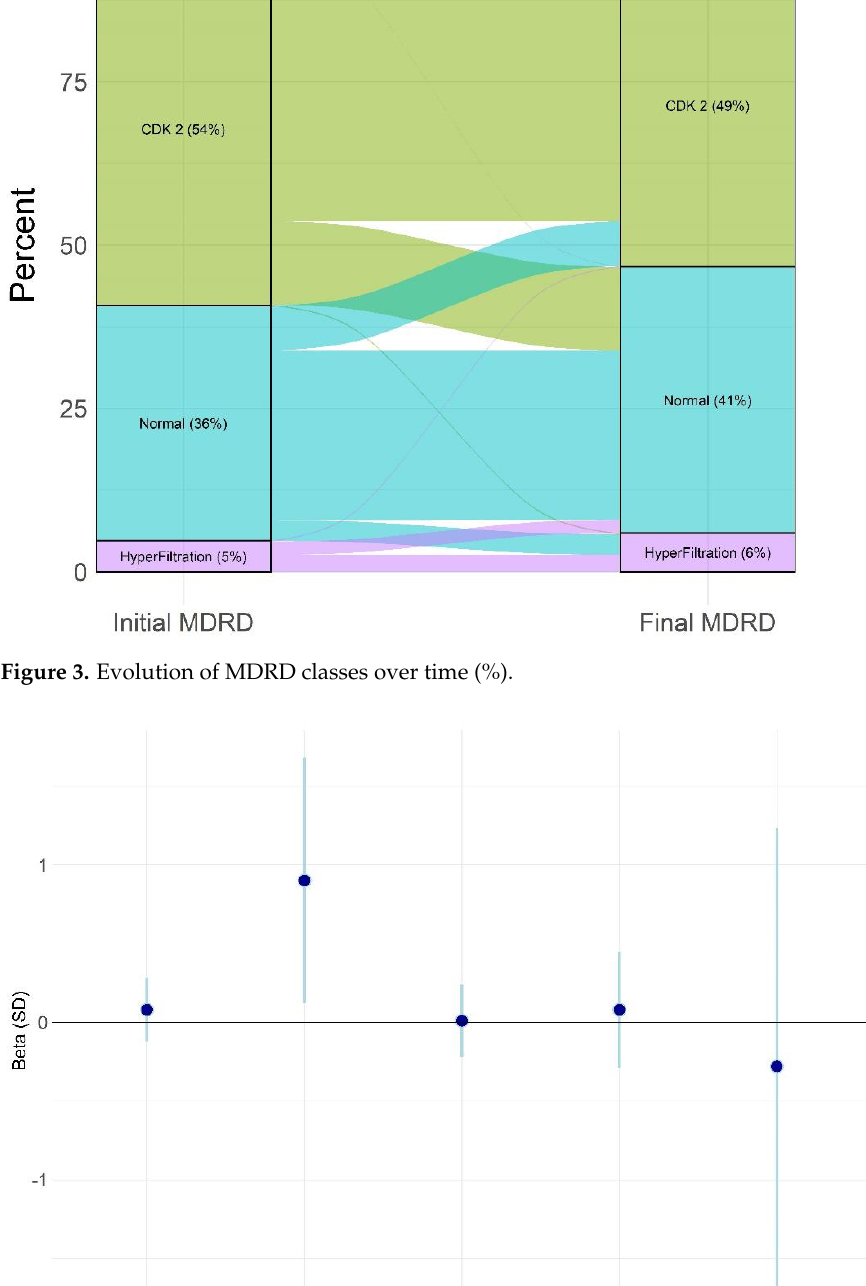
Figure 4. Effect of time on delta MDRD from multivariable linear model according to MDRD classes. Beta(SD): Effect size and 95% confidence interval for time effect on change in MDRD (final value— initial value) according to the initial class of MDRD from multivariable linear regression adjusted by age, sex, initial MDRD, and initial BMI.